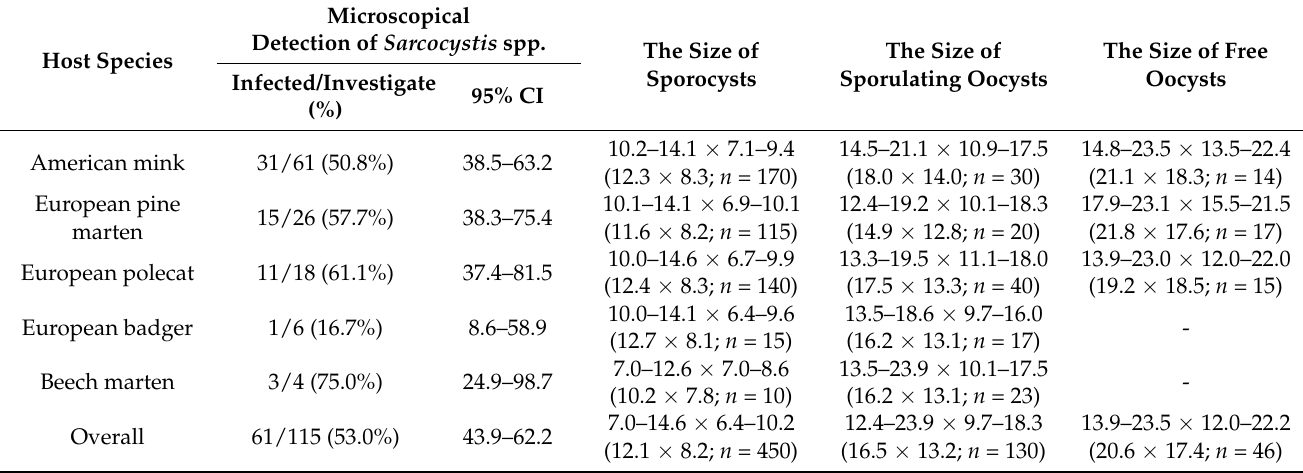
Table 1. Detection rates and morphology of oocysts/sporocysts found in small intestine mucosal scrapings of Mustelidae species from Lithuania.